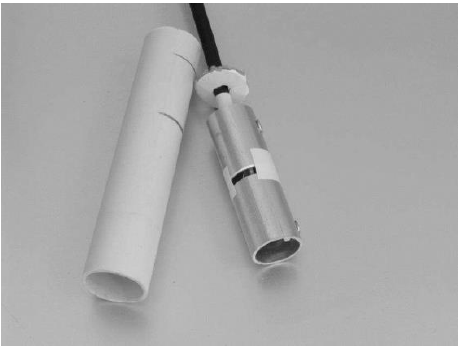
Figure 10. Capacitance probe with the plastic container disassembled.